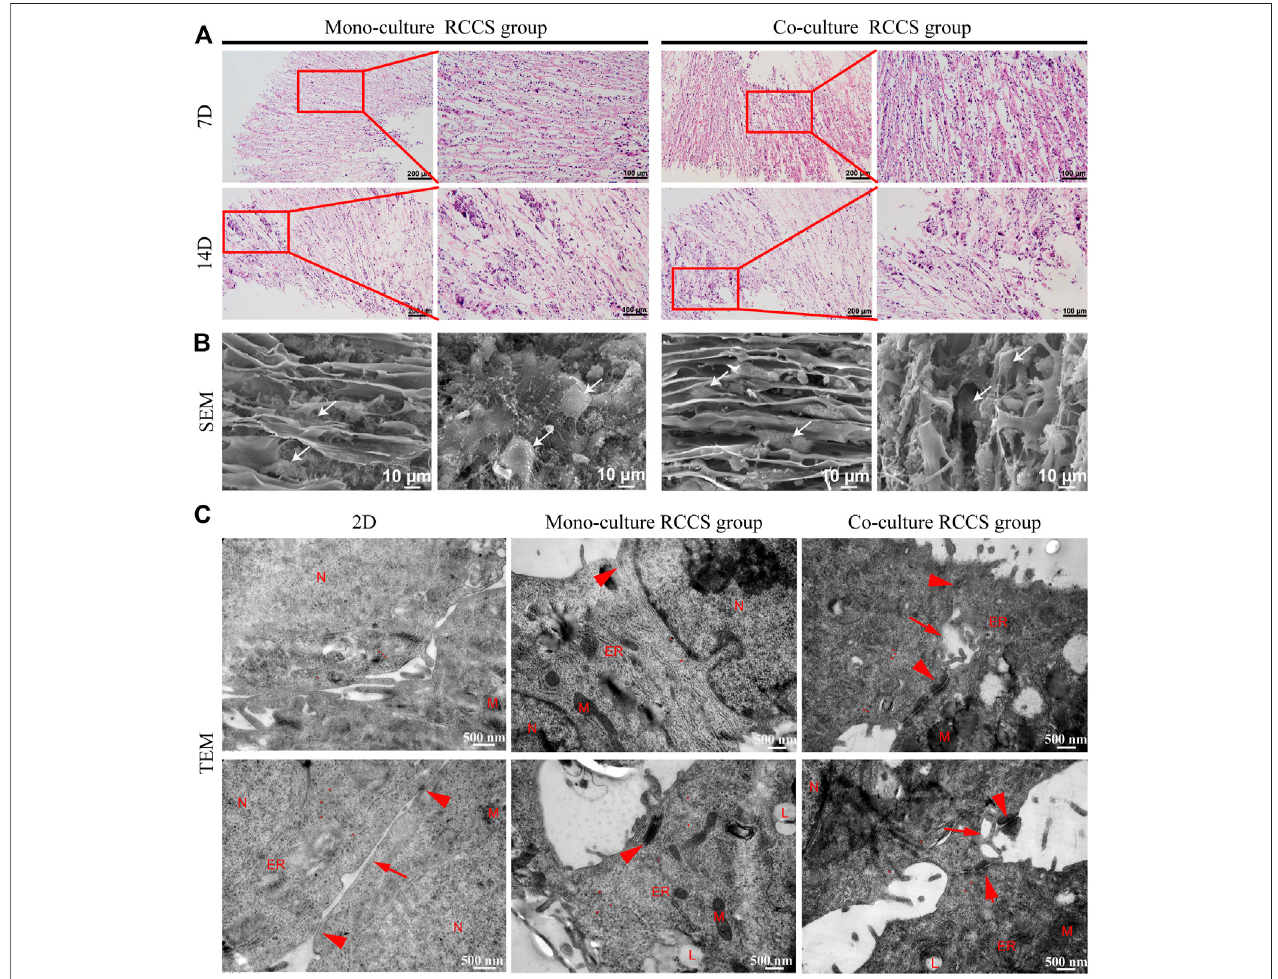
FIGURE 6 | Morphological characteristics of cells on composite SFC scaffolds. H&E staining (A) showed that cells displayed a compact but radially organized morphology.Locallyclusteredcellswereobservedafter14 days ofadynamic culture. SEMimages (B) showedthecellgrowth patternonthesurfaceofcomposite SFC scaffolds.Cells(whitearrows)exhibitedlongspindleorpolygonshapesandmigratedalongwiththeradialporesofscaffolds.UltramicroscopicTEMimages (C) indicated theimprovedmaturationofiHepLPC-Hepsafter3Ddynamicculturing,especiallymorecelljunctions(redarrowheads)andbilecanaliculi-likestructures(redarrows) were formed in co-cultured iHepLPC-Heps. (Nucleus- N, mitochondria- M, endoplasmic reticulum- ER, lipid droplets- L, red dot-glycogen).